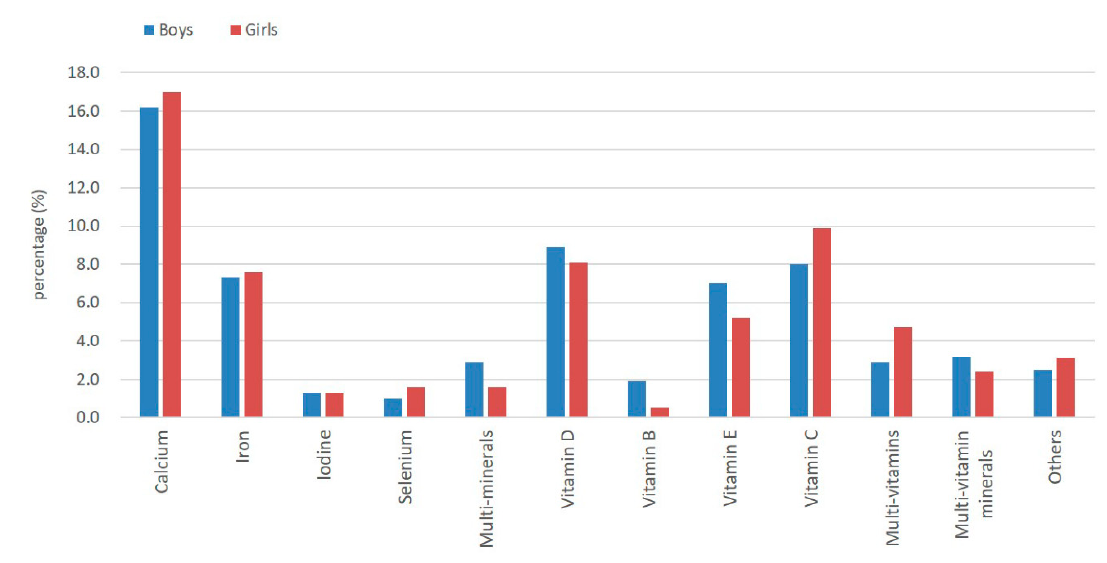
Figure 1. Percentages of different types of dietary supplements among primary students.